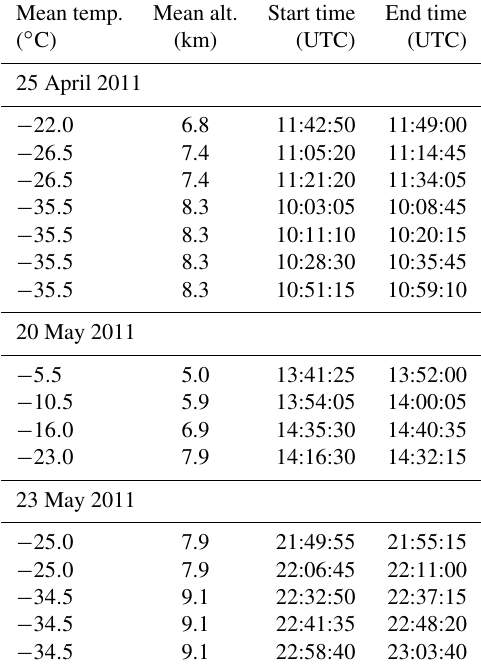
Table 1. List of constant-temperature flight legs used in the analysis for which coincident data between the ground-based radar and UND Citation exist. Start and end times, mean altitude, and temperature are displayed. Mean temp. Mean